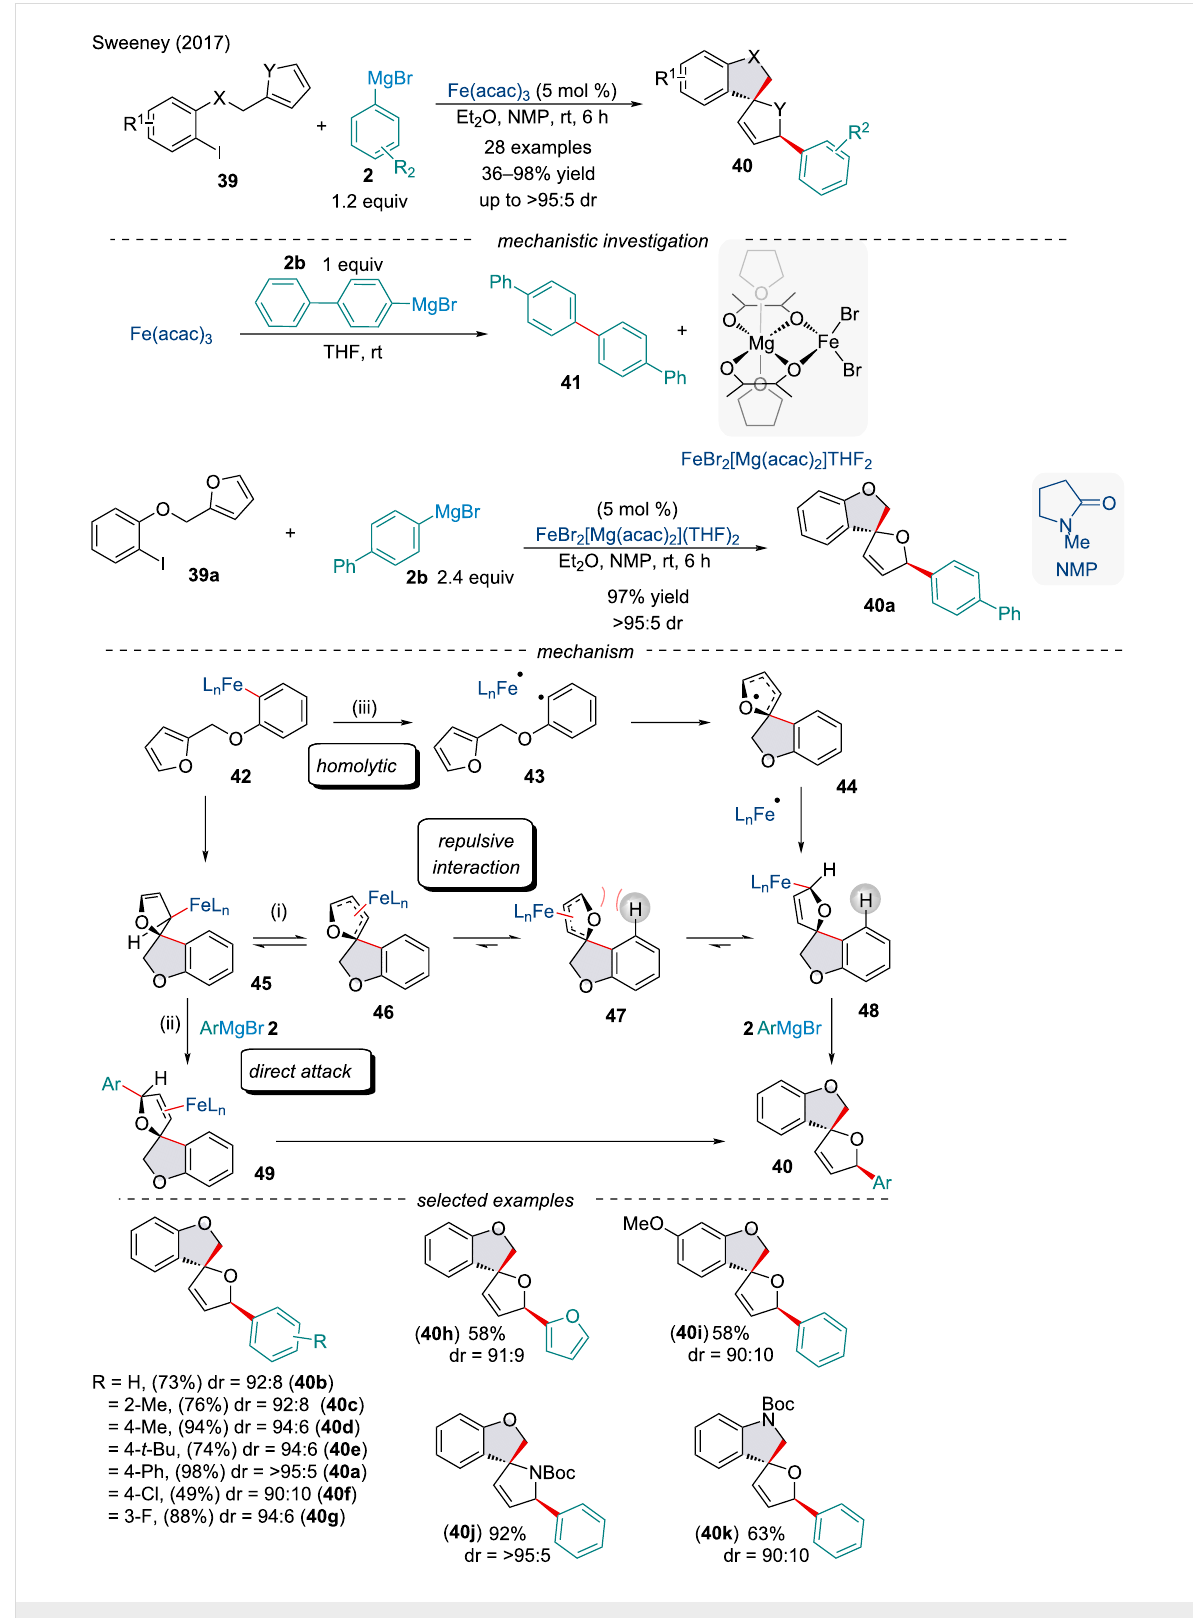
Scheme 8: Iron-catalyzed spirocyclization/cross-coupling